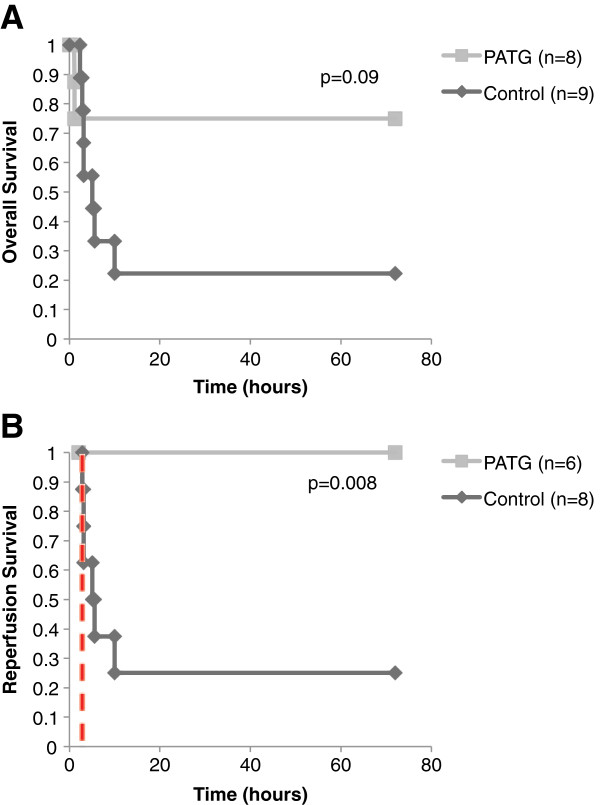
Kaplan-Meier survival curve for experimental groups versus control with log-rank test for statistical comparison. A) Overall survival. B) Reperfusion period survival. Dashed red line indicates end of hemorrhage and beginning of reperfusion period.